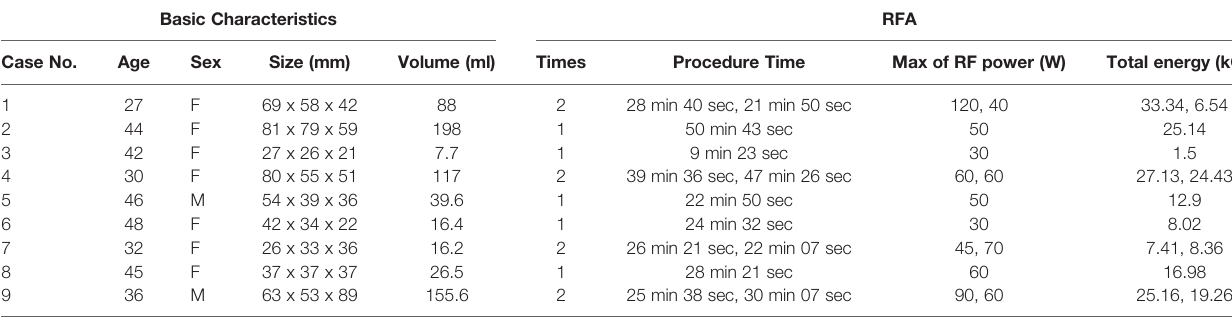
TABLE 1 | Baseline characteristics of the 9 patients with thyroid nodule rupture after RFA. Basic Characteristics